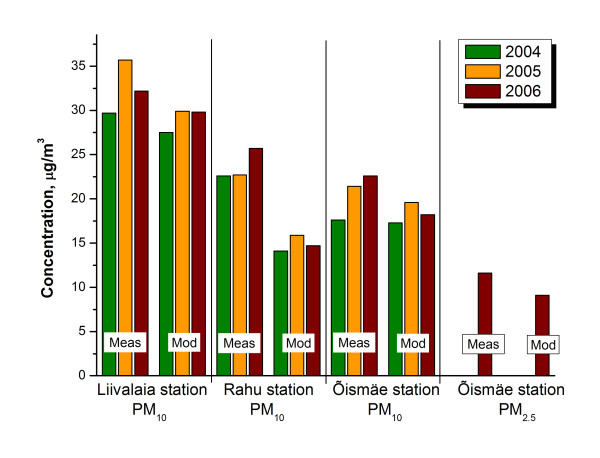
Measured and modeled PM10 yearly average in monitoring stations.